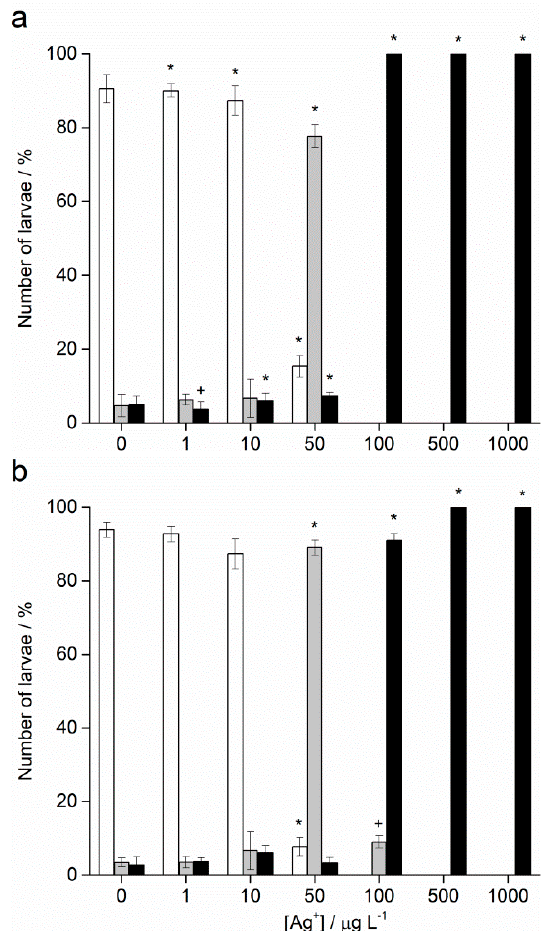
Figure 4. Percentage of normal (white bars) and developmentally delayed (grey bars) larvae, and undeveloped embryos (black bars) ( ± SD) of ( a ) A. lixula and ( b ) P. lividus exposed to various concentrations of Ag + ions. Significance levels: + p < 0.05 and * p < 0.001.